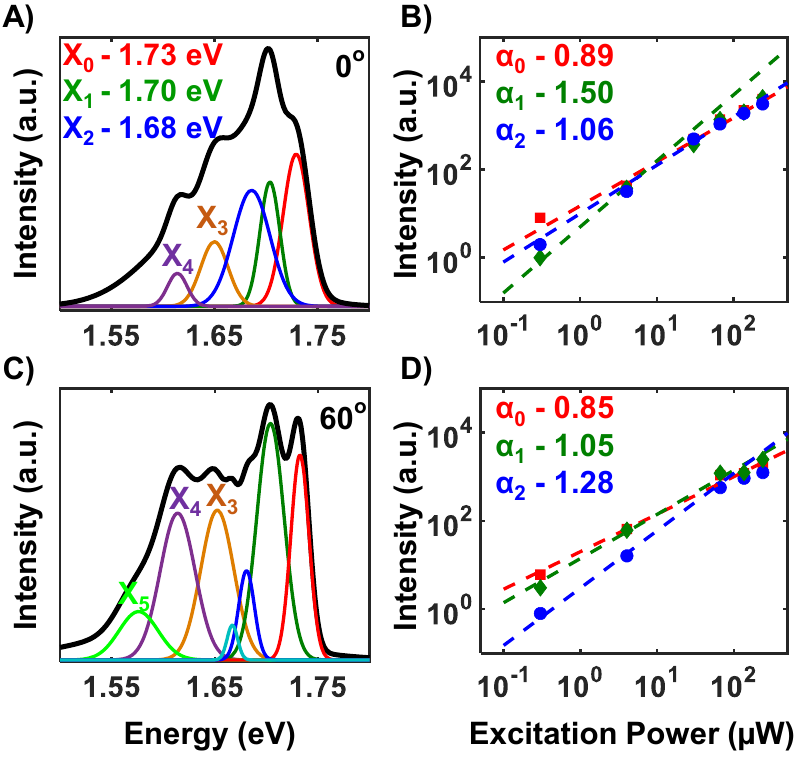
probe measurements were done on the fabricated bilayer samples as this was beyond the scope of this work.